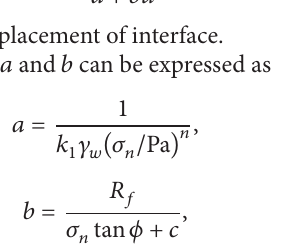
Figure 8: Shear strength envelops of two interfaces.